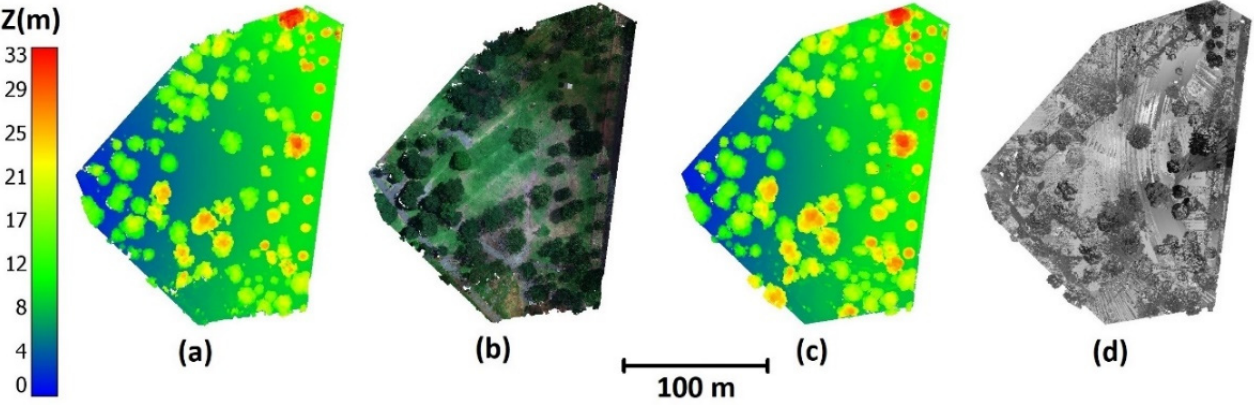
Figure 7. 3D point clouds covering the test area: ( a ) height-coded photogrammetric point cloud; ( b ) colourised Photogram- metric point cloud; ( c ) height-coded LiDAR point cloud and ( d ) intensity of LiDAR point cloud.